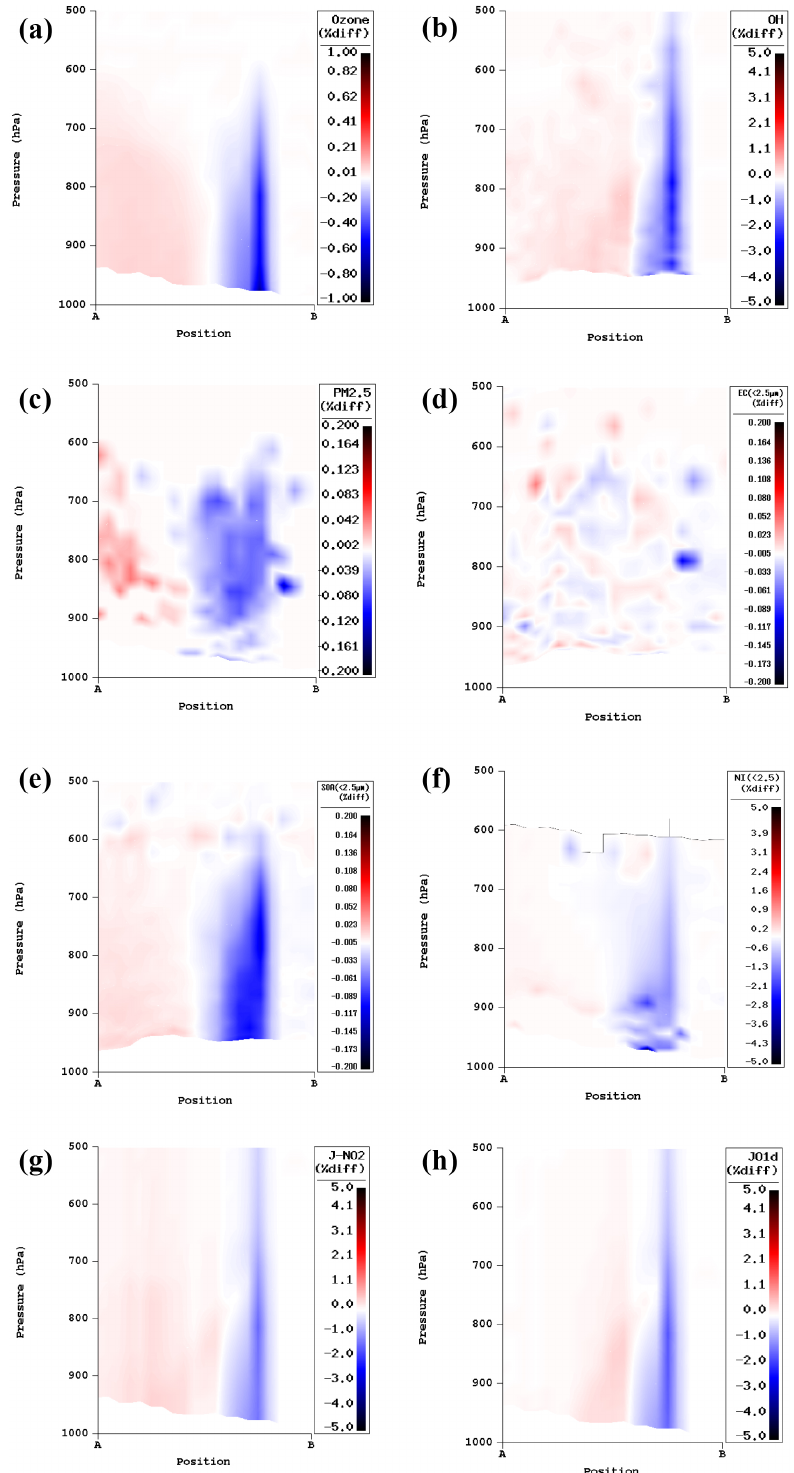
Figure 17. Cross sections of percentage difference in aerosol concentrations and photolysis rates with and without AOD calculations (no aerosol feedbacks) over the line shown in Fig. 14c, Lac La Loche forest fire on 25 June 2018 at 23:00UTC: (a) ozone (ppb), (b) hydroxyl radical (µgkg − 1 ), (c) PM 2 . 5 (µgm − 3 ), (d) EC ( < 2 . 5µm, µgkg − 1 ), (e) nitrate ( < 2 . 5µm, µgm − 3 ), (f) SOA ( < 2 . 5µm, µgkg − 1 ), (g) J (NO 2 ) (s − 1 ), (h) J (O 1 D) (s − 1